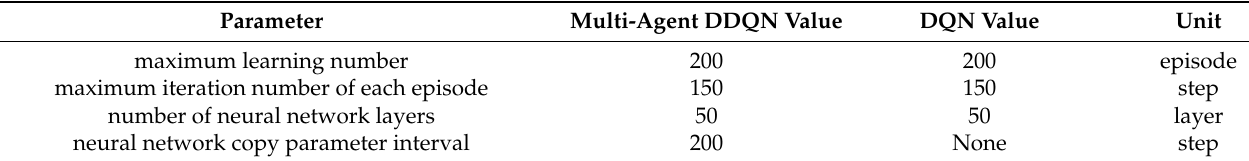
Table 4. Parameters of multi-agent DDQN and DQN.